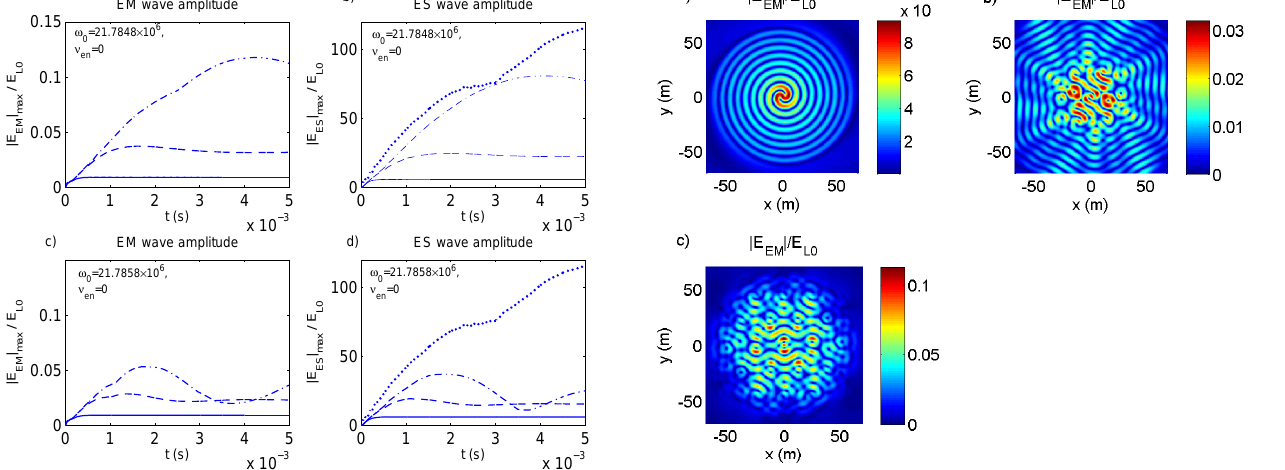
Figure 7. Simulations using shallow striations ( α = 0 . 01) and a col- lisionless model ( ν e = 0) showing the electromagnetic (EM) field amplitude associated with Z -mode waves (panels a and c ) and elec- trostatic (ES) amplitude associated with UH waves (panel b and d ) using a pump frequency of ω 0 = 21 . 7848s − 1 (panels a and b ) and a slightly higher frequency ω 0 = 21 . 7858s − 1 (panels c and d ), for 1 striation (solid lines), 7 striations (dashed lines) and 19 striations (dash-dotted lines). The wave frequency for the electromagnetic simulations was set to ω 0 = 21 . 786 × 10 6 s − 1 . The dotted line in panels (b) and (d) shows the result of an electrostatic simulation on the resonant frequency ω 0 = 21 . 799 × 10 6 s − 1 , corresponding to the lowest radial mode for N = − 1 and R = 1 in Fig. 2b.